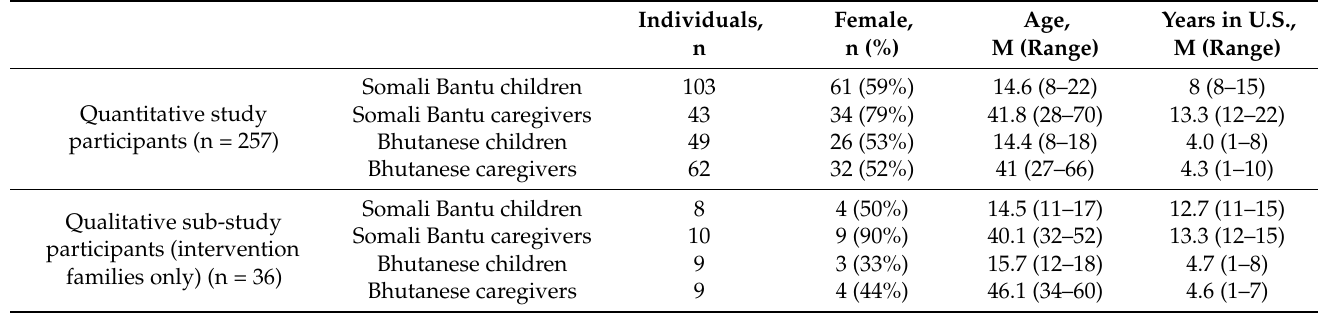
Table 1. Demographic characteristics of family participants in quantitative and qualitative portions of the study. Individuals,